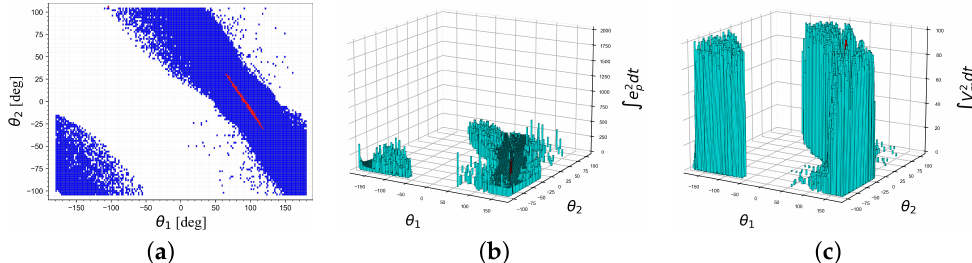
(cid:82) (cid:82) e 2 p dt , (( c ) V 2 m dt .